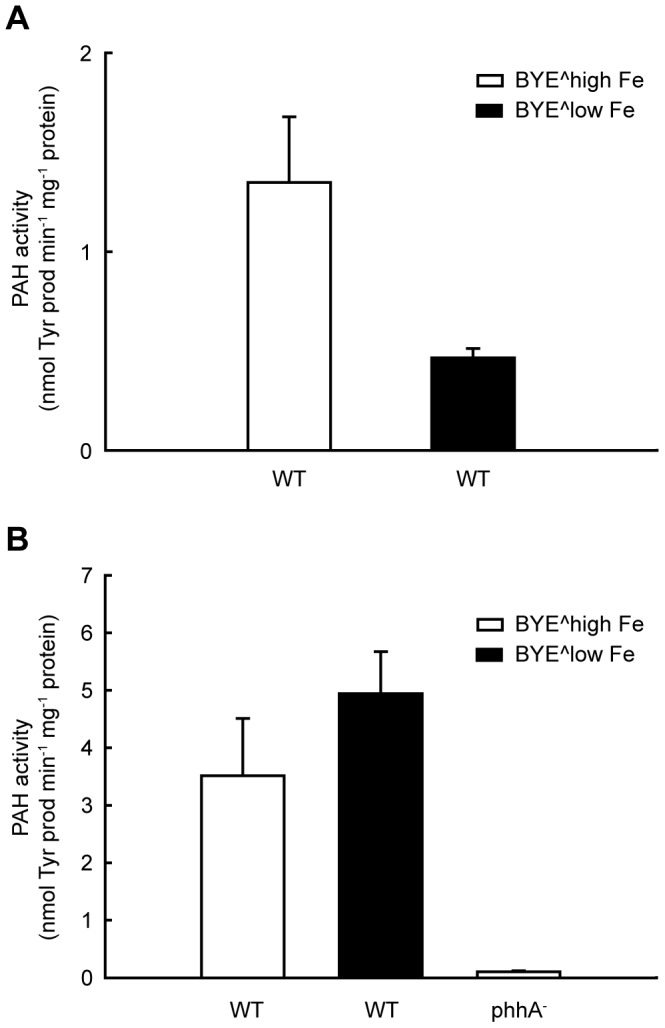
PAH activity in lysates of L. pneumophila 130b.PAH activity measured without (A) and with (B) the addition of 100 µM Fe(II) in the assay in lysates from wild-type (WT) cultures grown in BYE medium with (BYÊhigh Fe; white bars) and without (BYÊlow Fe; black bars) standard (1.3 mM) FeCl3 supplement (see text for details). The data presented are the means and SD from triplicate measurements of duplicate cultures for each condition. The activity of a lysate of a culture of phhA mutant grown in BYÊhigh Fe is also shown in (B). Differences between conditions were found to be significant (P<0.01) with respect to WT in BYÊhigh Fe, in both (A) and (B).